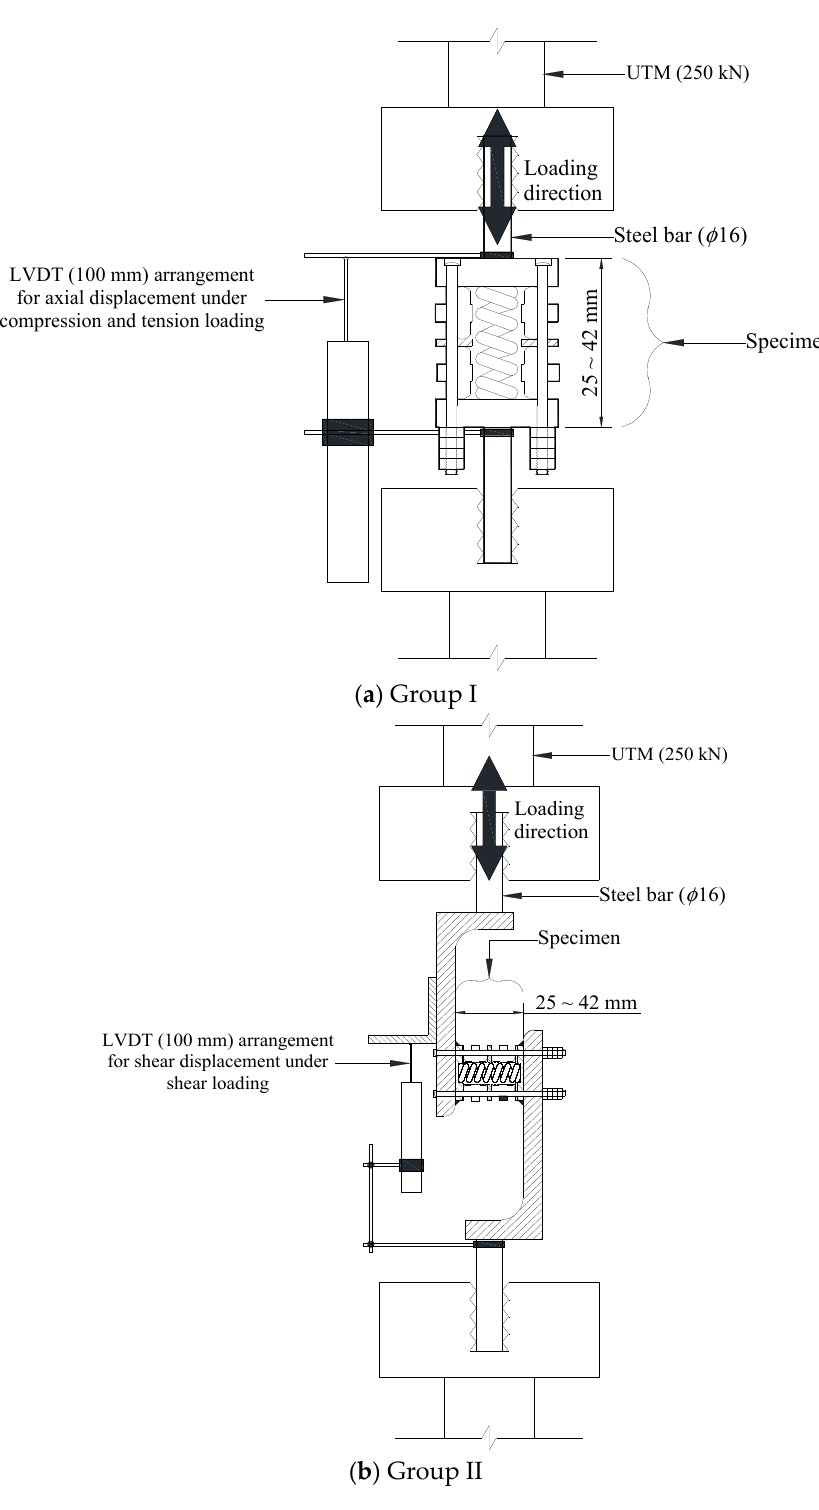
Figure 3. Test set-up: ( a ) Group I; ( b ) Group II.